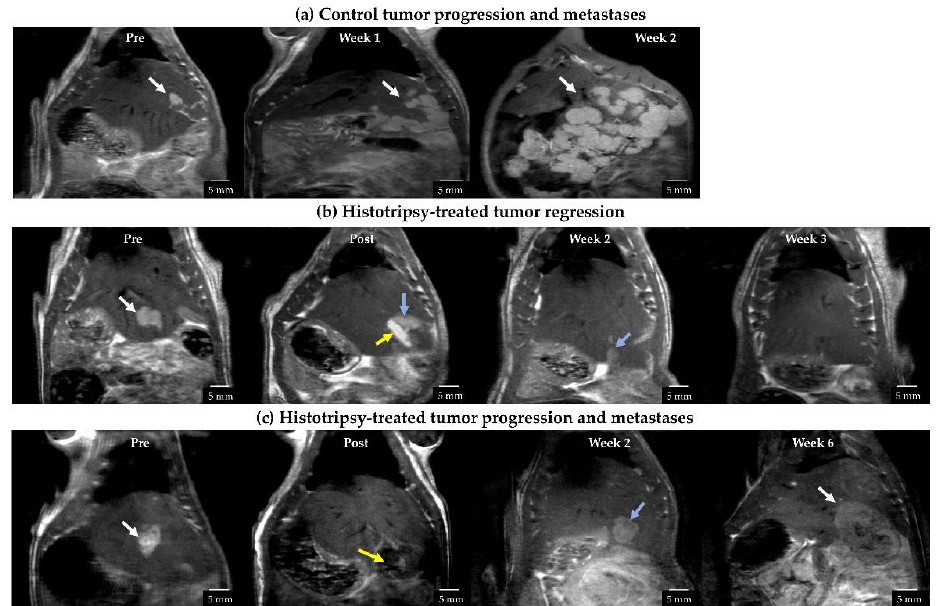
Figure 3. Representative T2-weighted MR images for ( a ) untreated control, ( b ) histotripsy-treated tumor showing complete regression, and ( c ) histotripsy-treated tumor with local tumor progression. ( a ) Untreated control tumor appeared hyperintense compared to surrounding liver parenchyma at pre-treatment timepoint, developed metastases at week 1 which grew aggressively by week 2. White arrows show the tumor location. ( b ) Post-ablation, the ablated region appears hyperintense (yellow arrow) compared to untargeted tumor (blue arrow) likely due to edema (image acquired 8 h post-treatment). By week 2, tumor appeared to regress (blue arrow) and was undetectable from week 3 onwards. ( c ) Post-ablation, the ablated region (yellow arrow) appears hypointense (image acquired within 2 h post-treatment). At week 2, the tumor did not show signs of size regression (blue arrow). Local tumor progression and metastases were observed by week 6 (white arrow).